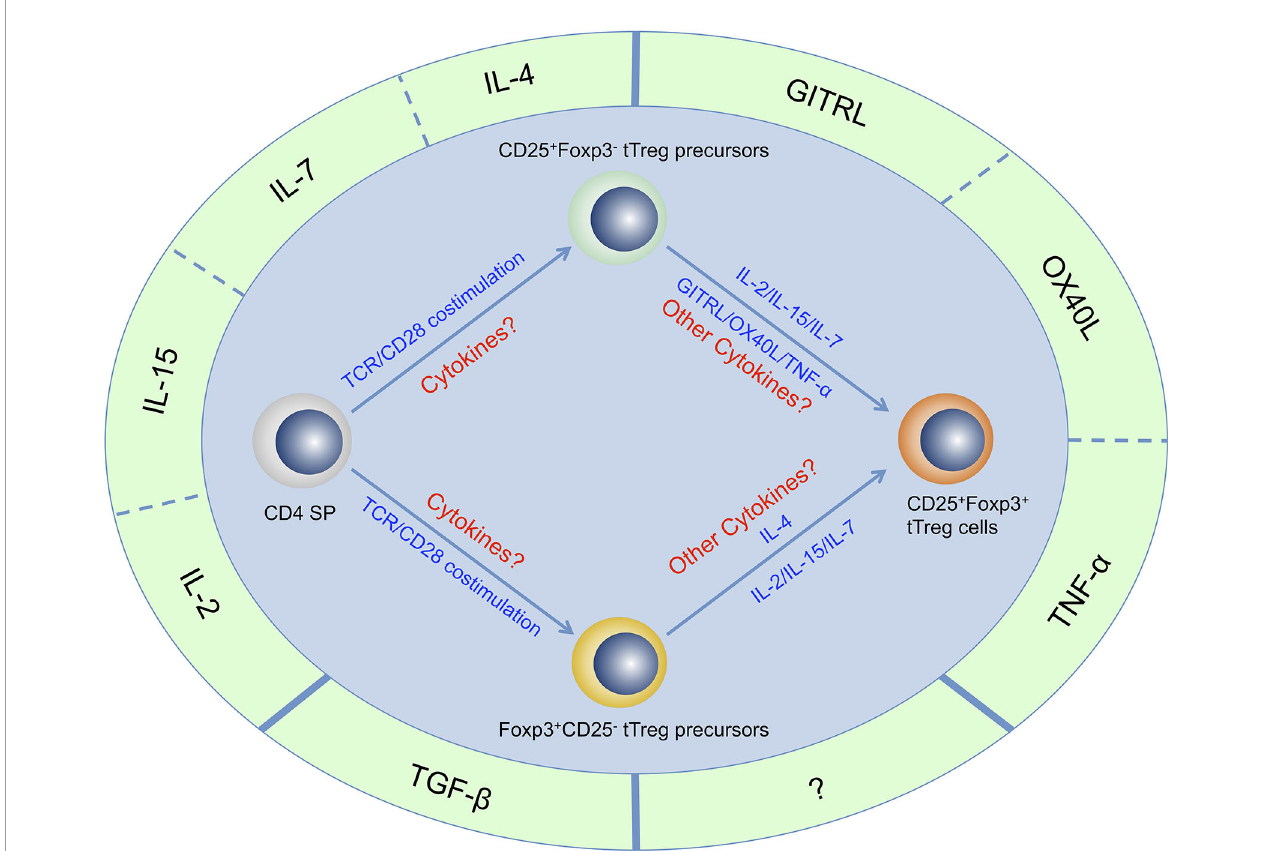
FIGURE 1 | Cytokines that are important for tTreg cell generation. Four g c family cytokines (IL-2, IL-4, IL-7, and IL-15), Three TNF superfamily cytokines (GITRL, OX40L, and TNF- a ) and TGF- b have been determined to be important for tTreg cell generation. There may be other cytokines that are important for tTreg cell generation but have not yet been identi fi ed. It has been proven that CD4 + CD8 - Foxp3 - CD25 + thymocytes and CD4 + CD8 - Foxp3 + CD25 - thymocytes are two populations of tTreg cell precursors that generated through two distinct developmental programs, but the regulatory network of these cytokines in the development of these two precursor populations and mature tTreg cell has not been fully